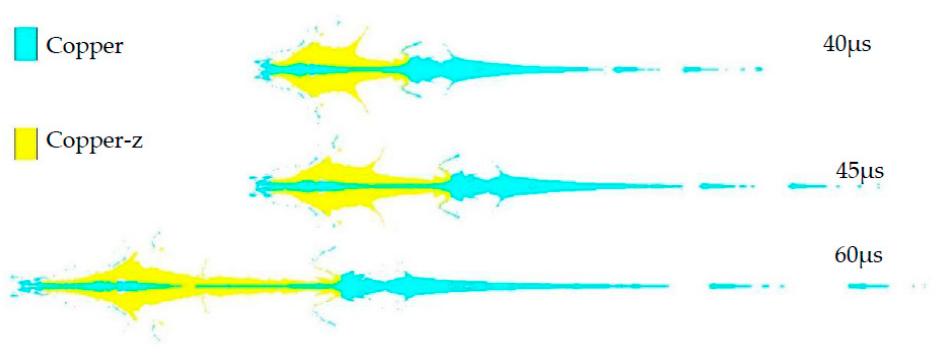
Figure 8. Jet morphology of charge with shell.